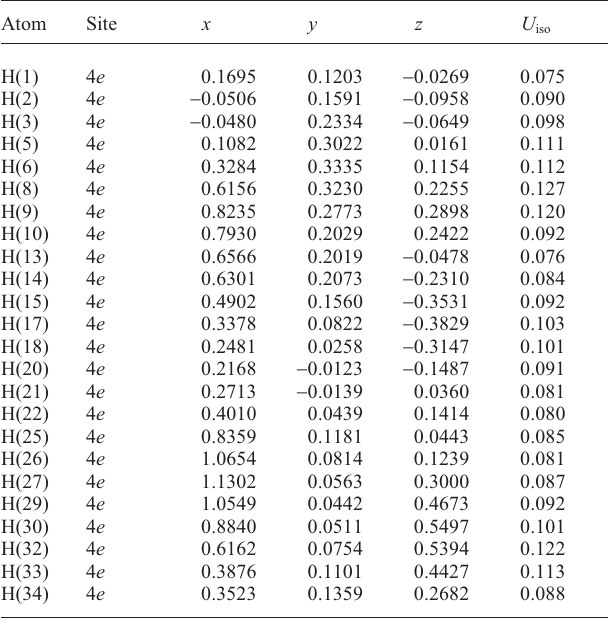
Table 2. Atomic coordinates and displacement parameters (in Å 2 )